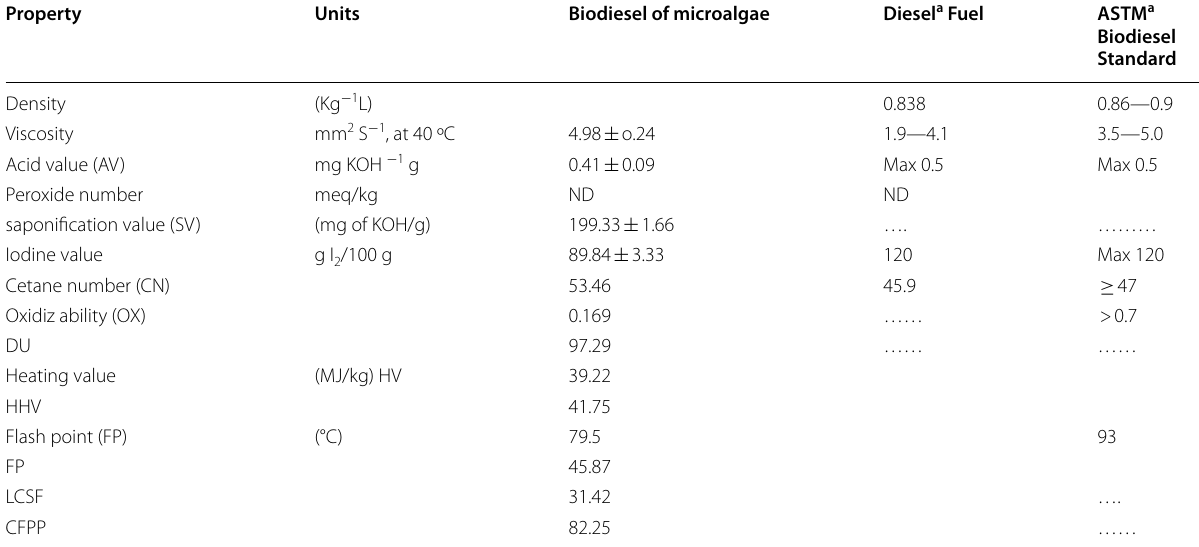
a The data about diesel and ASTM biodiesel standard were taken from published